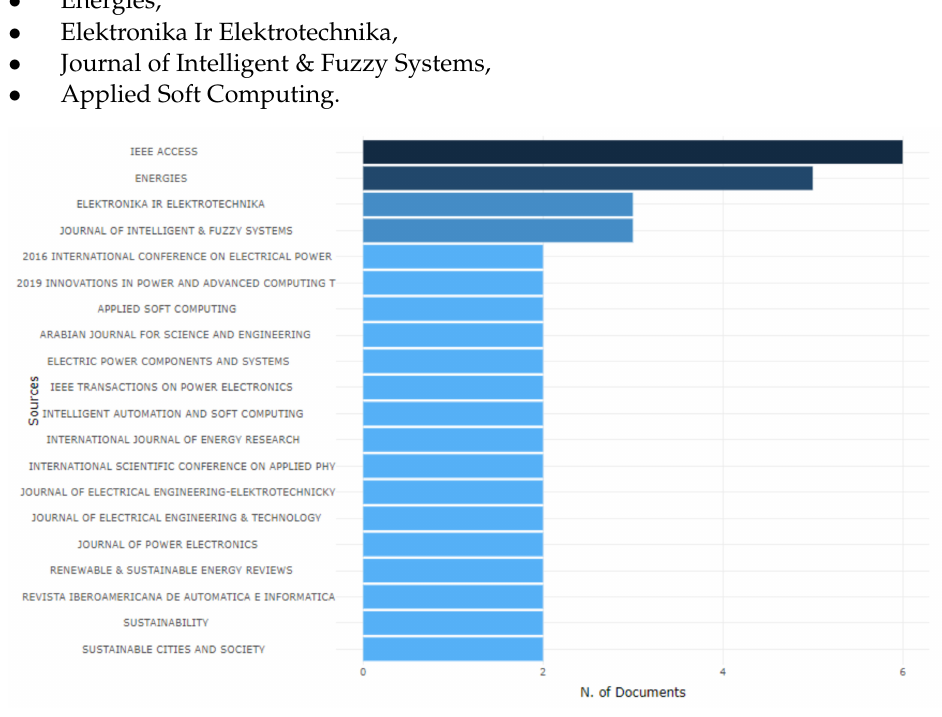
Figure 17. The most relevant sources according to Web of Science.